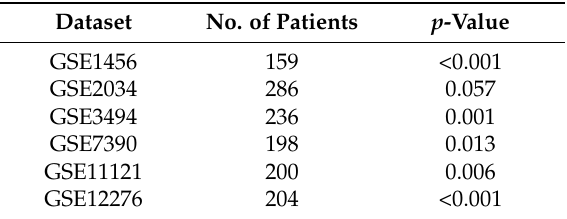
Table 2. Summary of the survival analysis in breast cancer patient